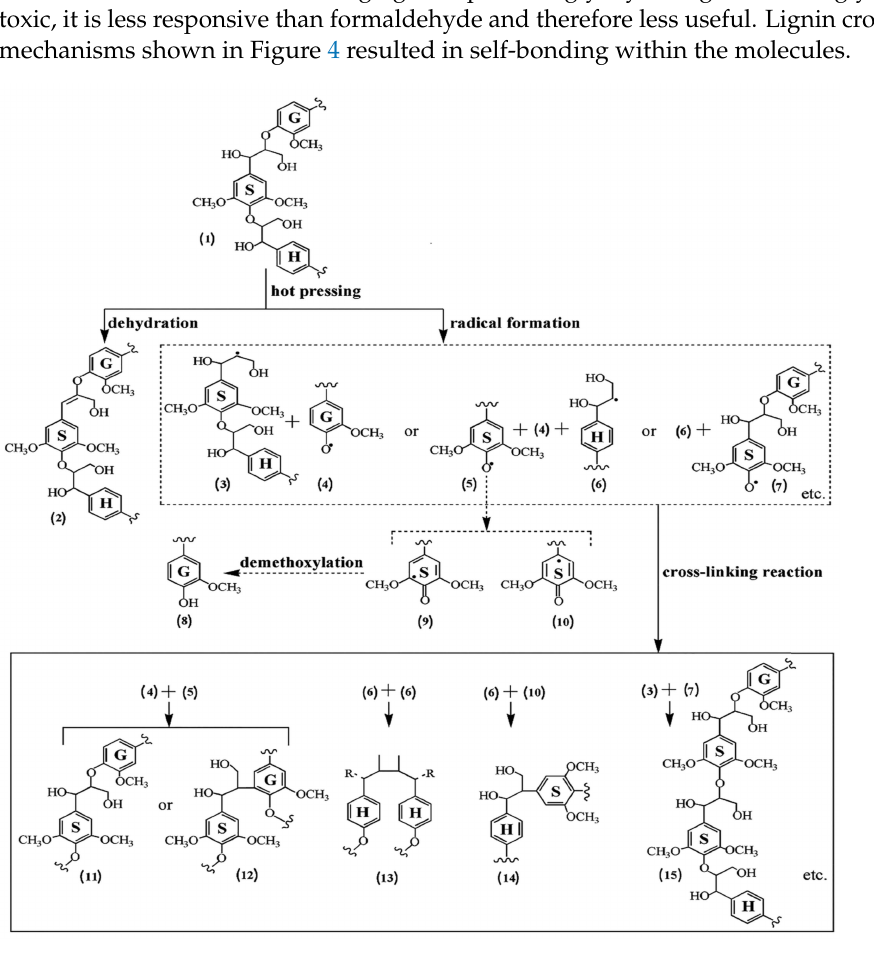
Figure 4. Cross-linking mechanisms for lignin, Reproduced from [157], ACS Publications,